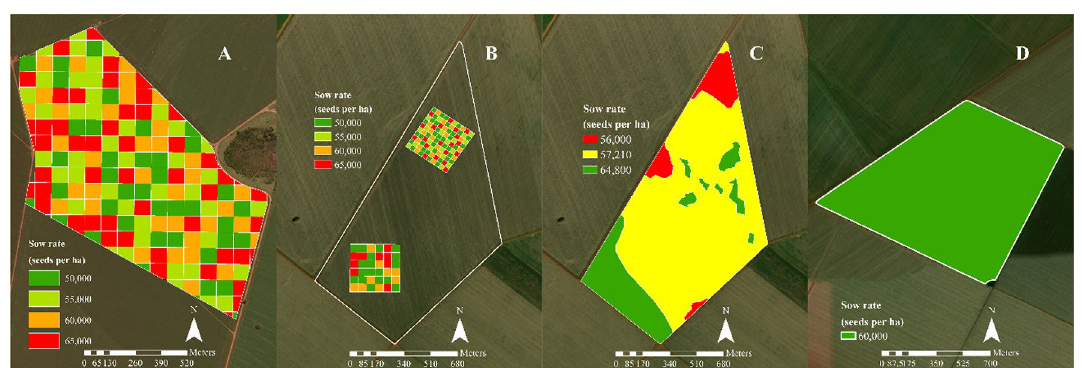
Figure 2. Experimental plots and planned seeding rates for sites A and B in the 2017/2018 cropping season and sites C and D in the 2018/2019 cropping season (used to validate the results). The software used to create this Figure was ArcGIS Desktop (v10.5, https:// deskt op. arcgis. com/ en/ system- requi remen ts/